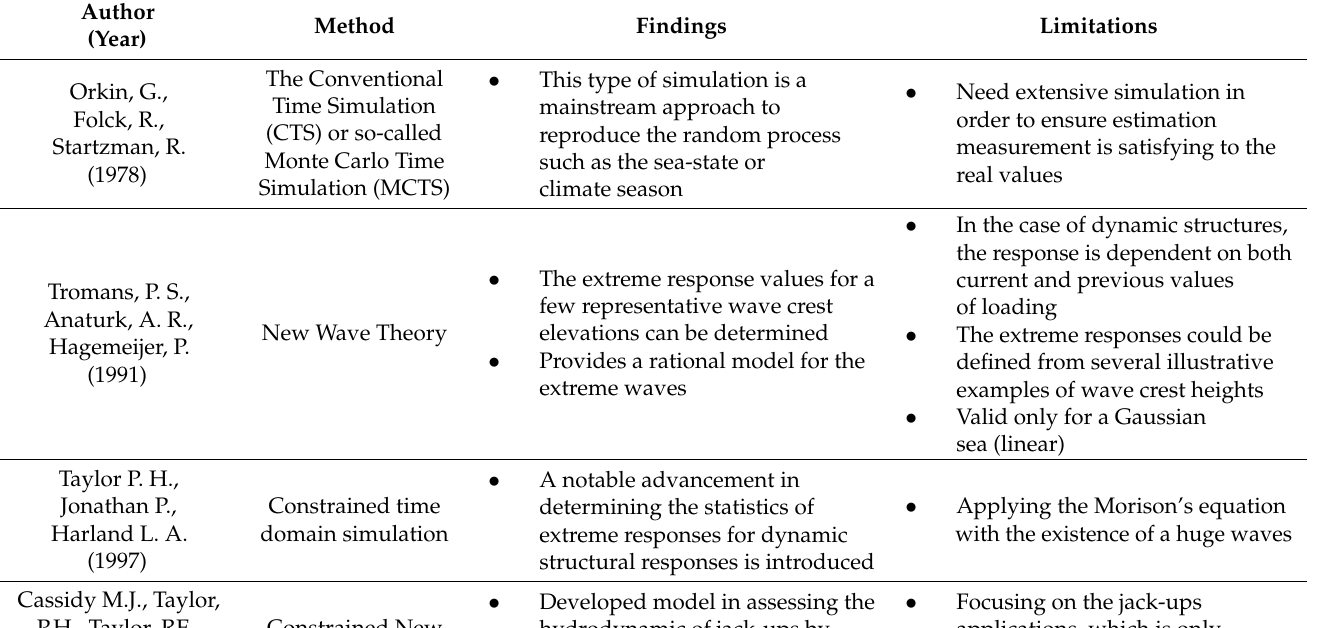
Table 3. Time domain method in evaluating extreme